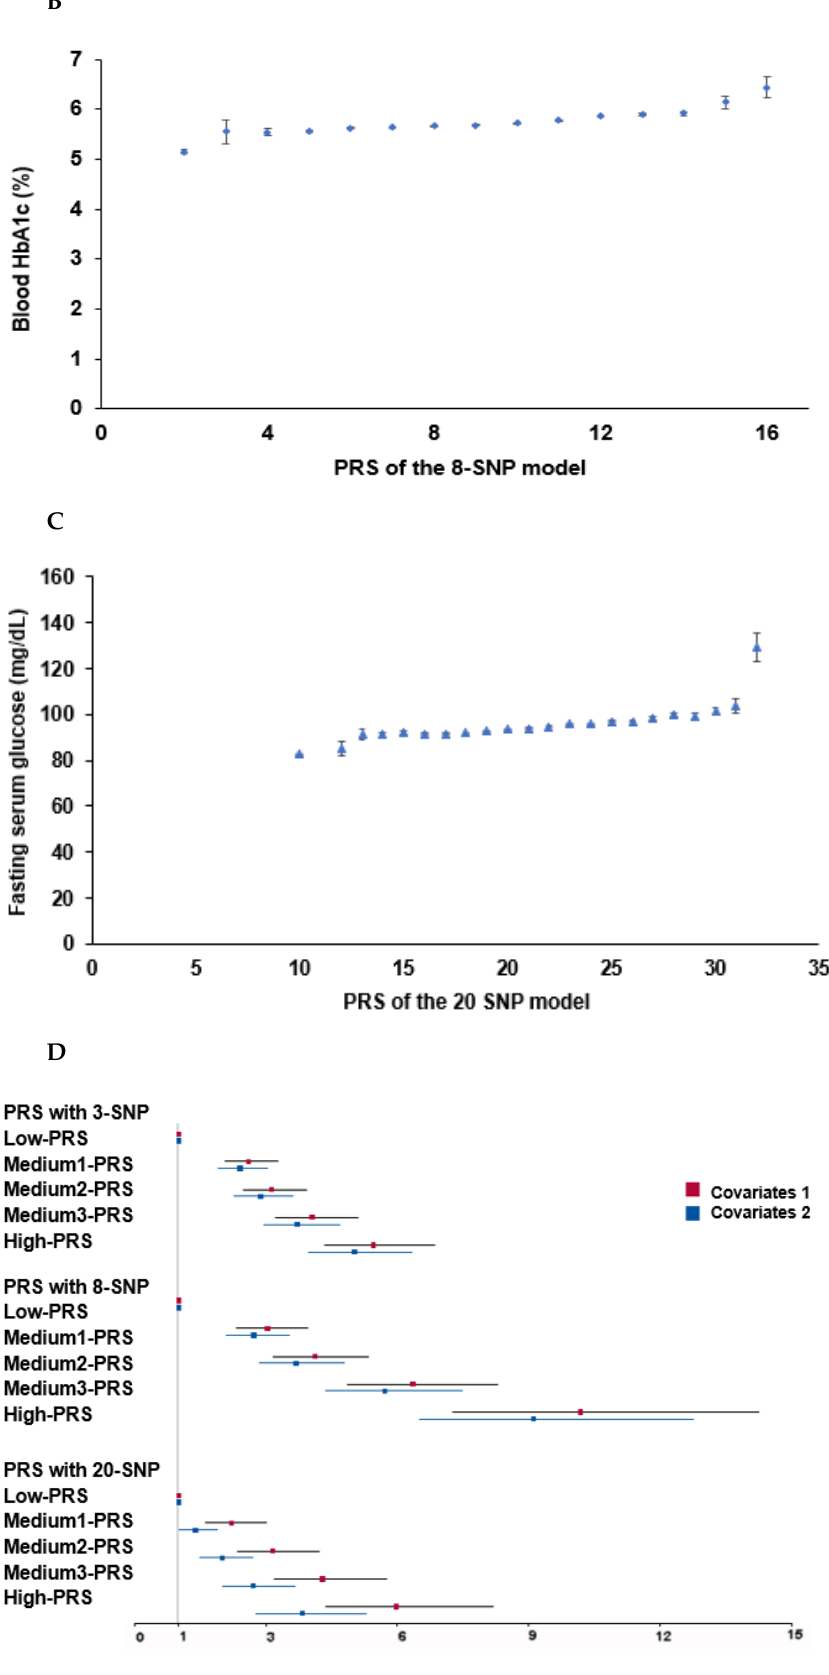
Figure 3. Association of polygenic risk scores (PRS) to type 2 diabetes risk: ( A ) A plot between